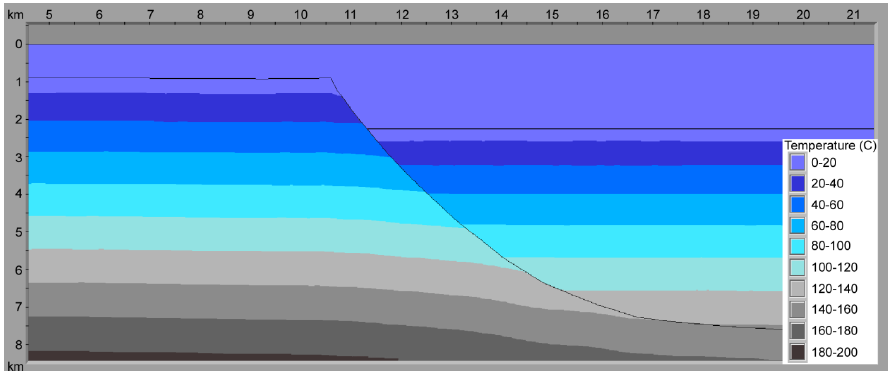
Figure 4. Temperature regime in the uppermost 8 km of the basin 1000 years after fault movement and sediment deposition. Fault slip is 1200 m.